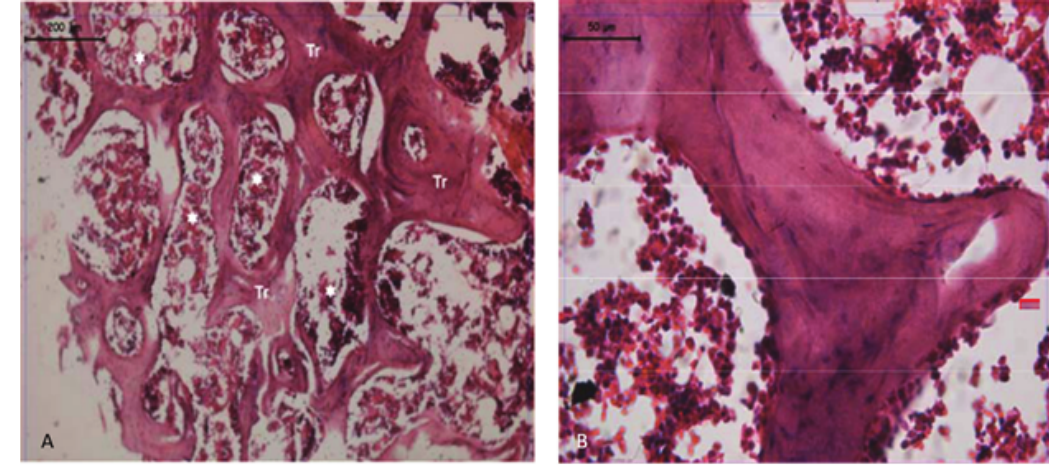
Figure 1: Microscopic view of the femoral neck in the control group. Tr: trabeculae; *Bone marrow tissue (Hematoxylin–Eozin).